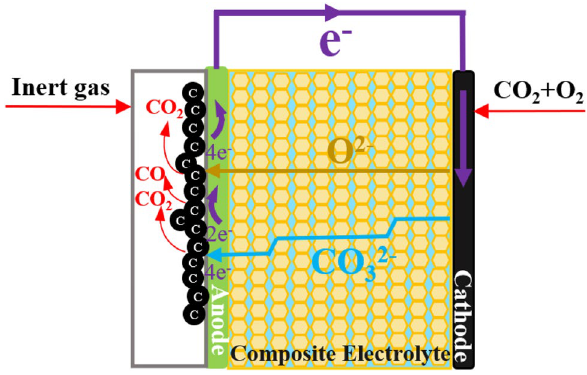
Fig. 4 Schematic of DCFC with a composite electrolyte: CO receive electrons and produce carbonate ion; only O 2 receives elec- trons and produces O 2− at the cathode. Then, the O 2− and carbonate ions are transferred to the anode through a composite electrolyte, and react with carbon to produce CO, CO 2 and